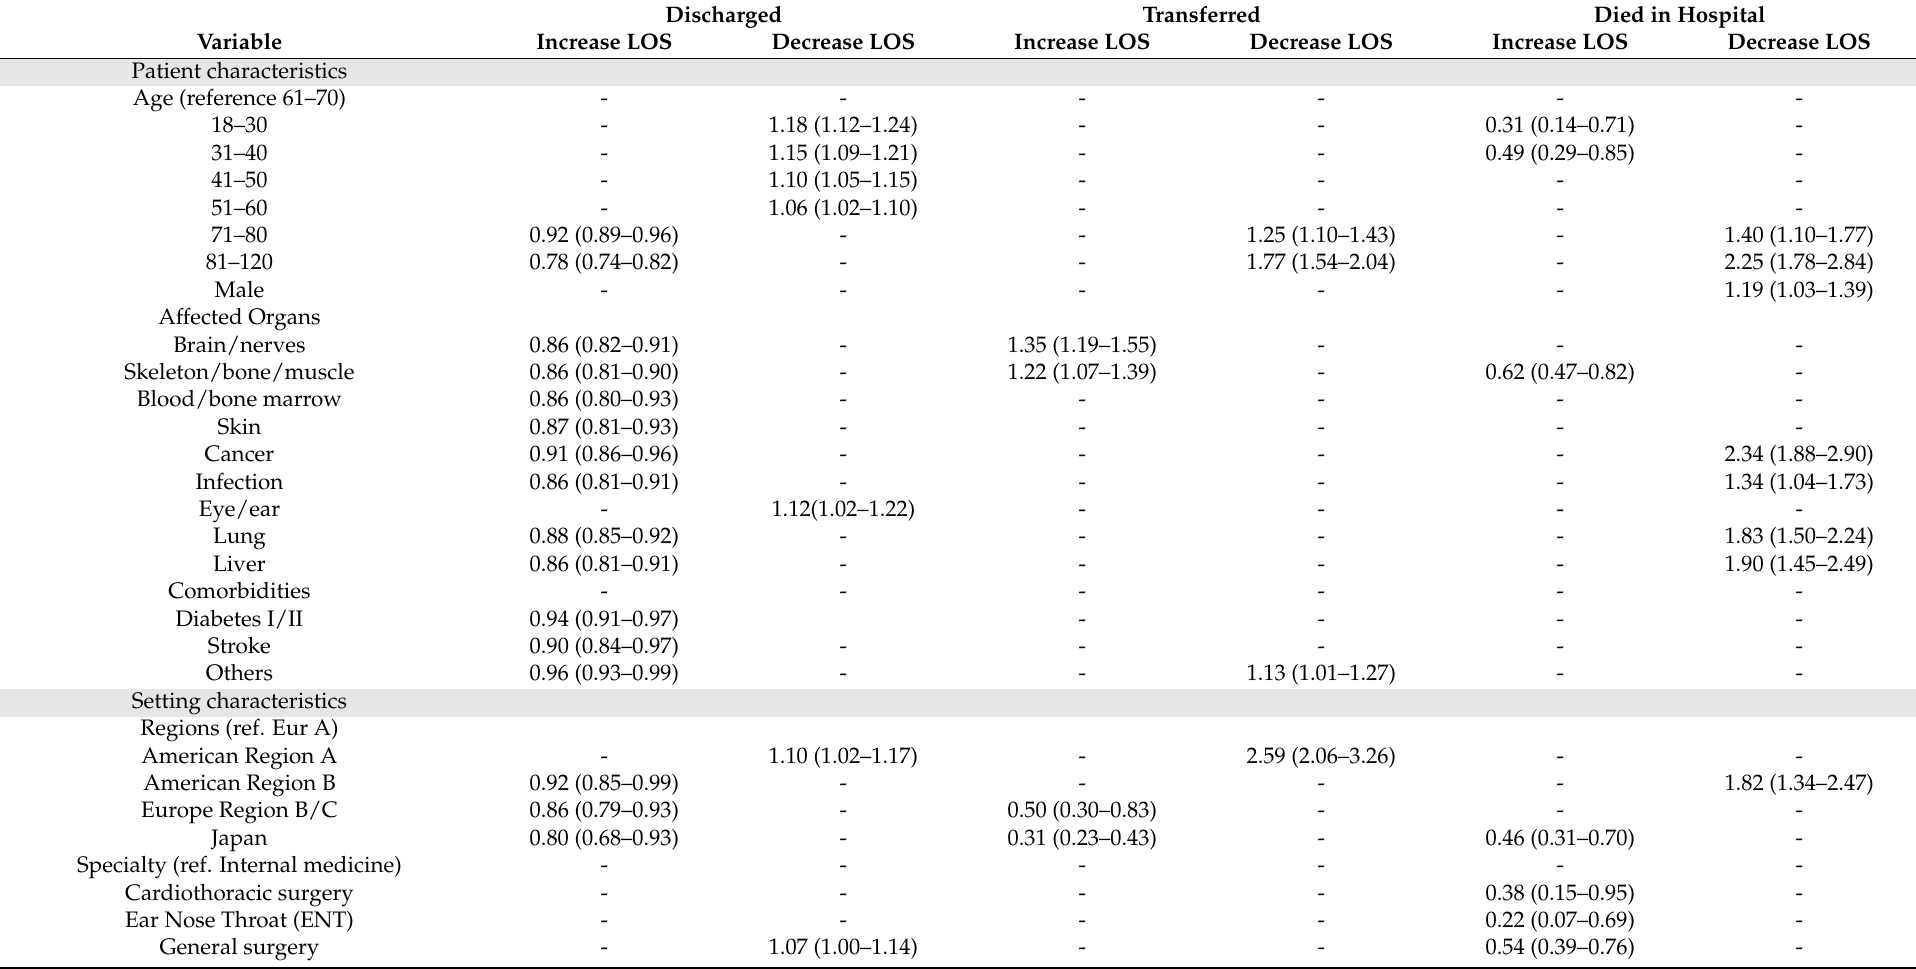
Table 2. Hazard ratios and confidence intervals for statistically significant * determinants of length of stay (based on multivariable global model